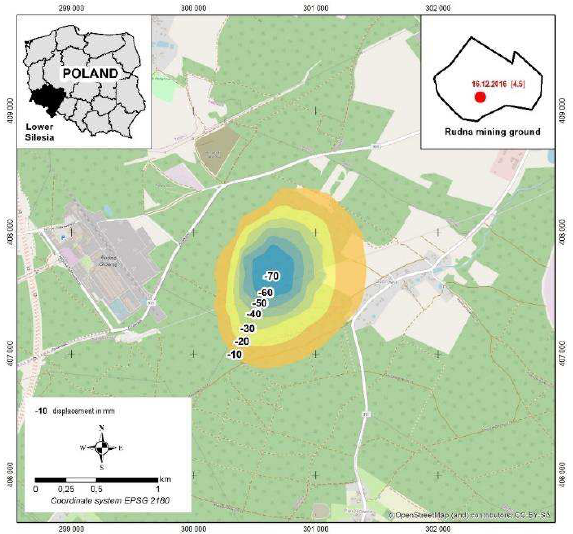
Figure 8. Map of the deformation resulting from the seismic event of 26 December 2017